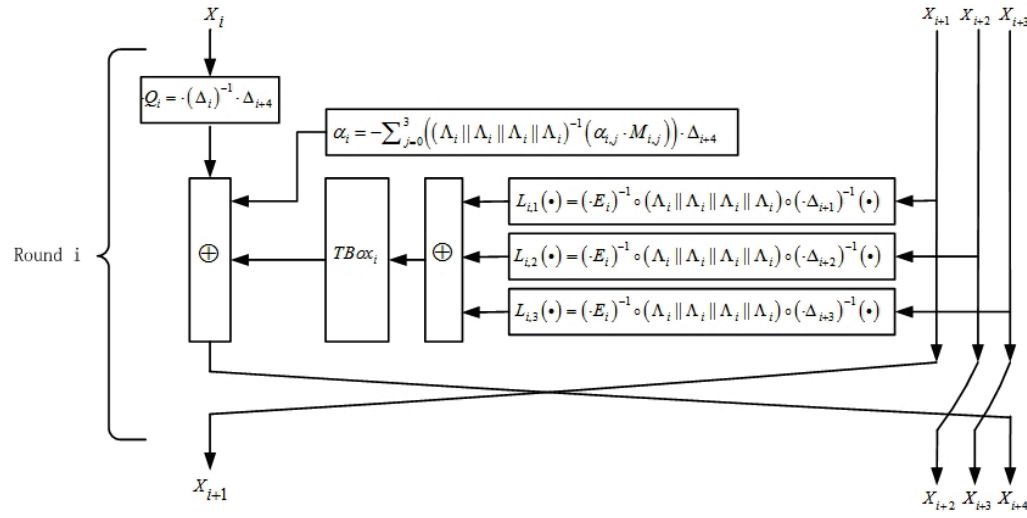
Figure 4. The structure of an intermediate